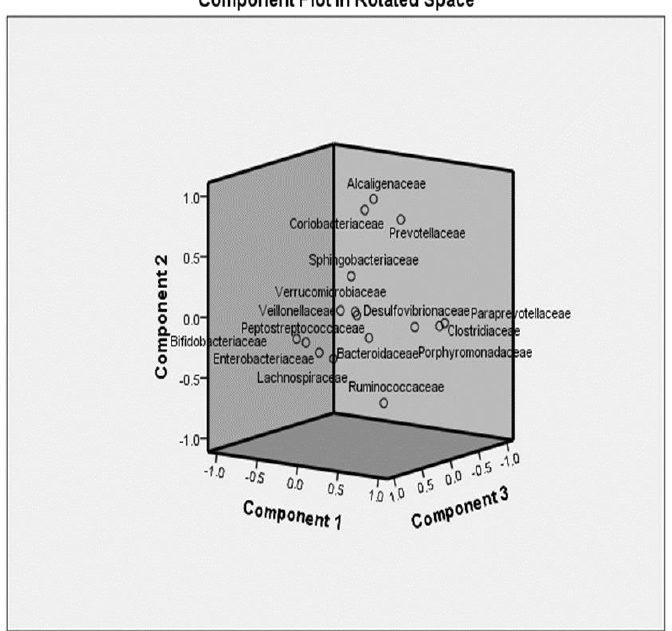
Fig. 1b. Spatial view of the relationship of the extracted factors with bacteria family-groups among